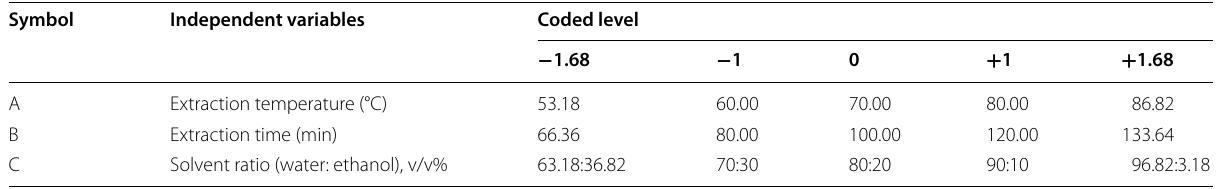
Table 1 Coded independent variables used in CCRD design Symbol Independent